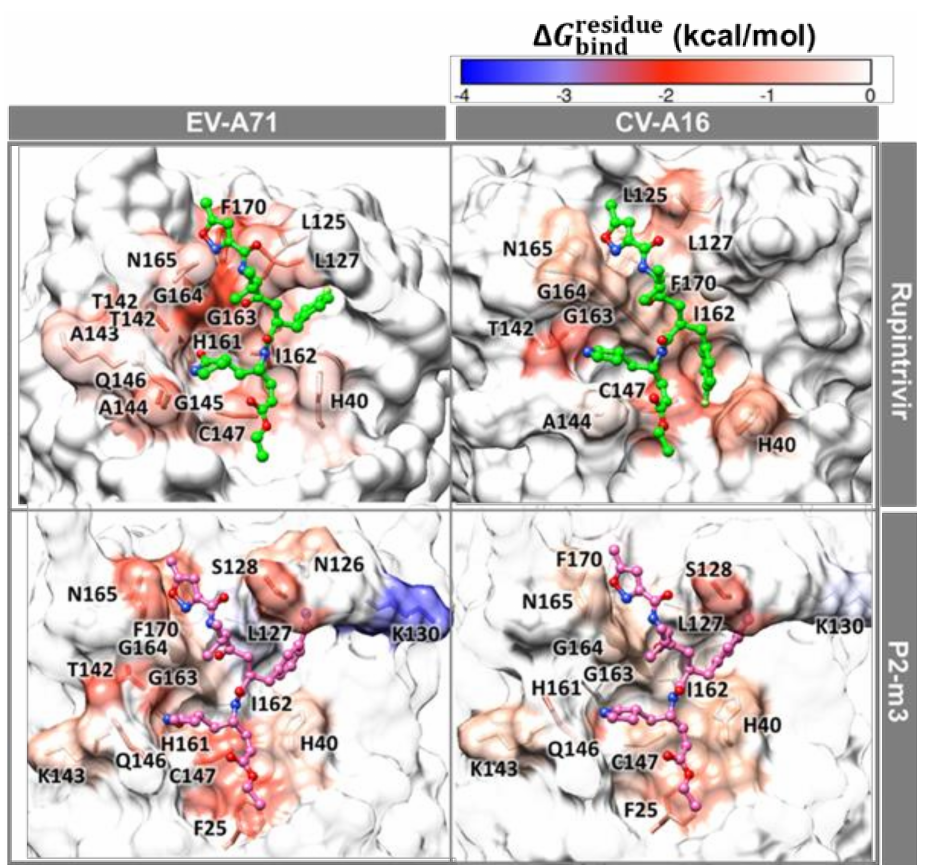
Figure 7. The contributing residues involved in ligand binding are colored according to the per- residue decomposition free energy ( ∆ G residue ), where the highest to lowest free energies are shaded bind from white to